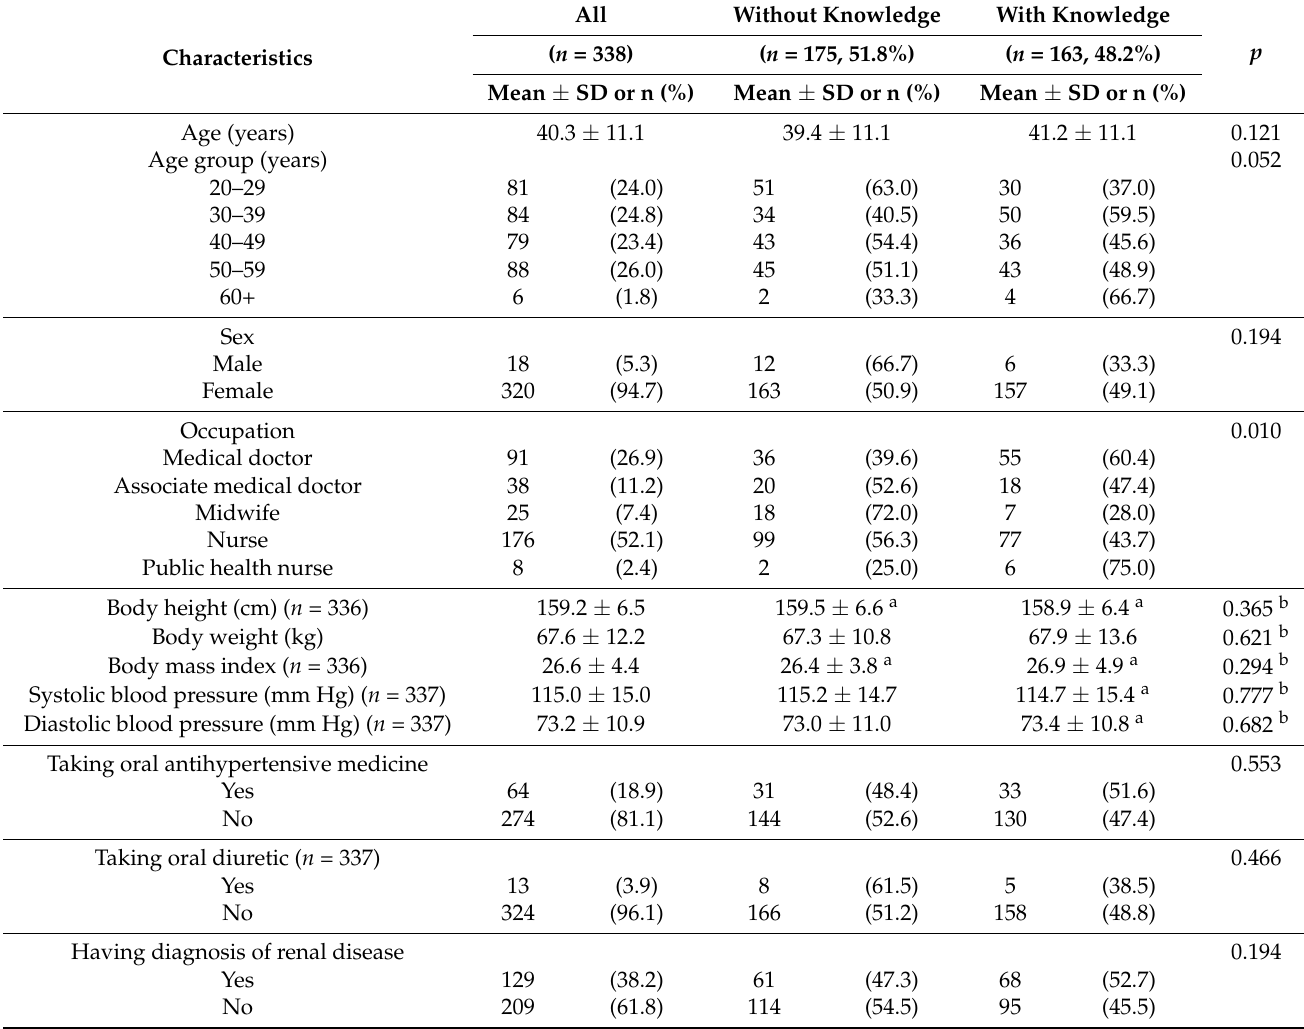
Table 1. Characteristics of participants ( n = 338).